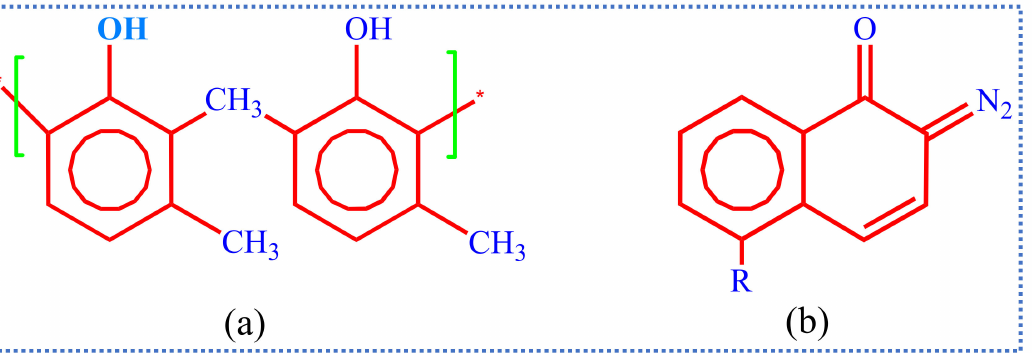
Figure 3. Chemical structure of ( a ) novolac polymer; and ( b ) diazoquinones photoactive compound used in most commercial i-line